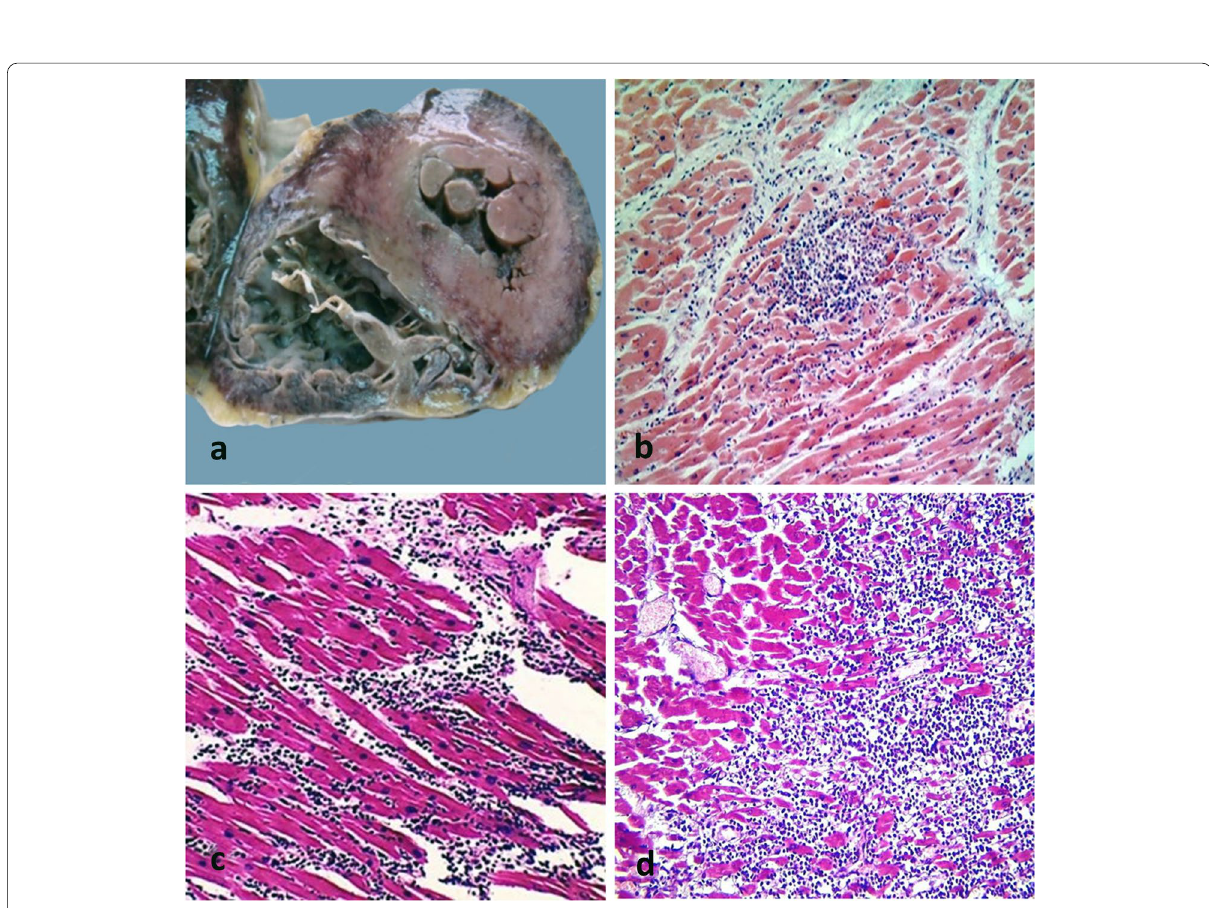
Fig. 3 Myocarditis. a , b Neutrophilic myocarditis. a A heart with yellowish areas in the myocardium and red foci of congestion; b histopathological picture of myocarditis showing neutrophilic inflammatory cells infiltrating the myocardium with myocyte necrosis and abscess formation in (H&E 100); c , d histopathological pictures of lymphocytic myocarditis showing lymphocytic inflammatory cells infiltrating the cardiomyocytes with × myocyte necrosis